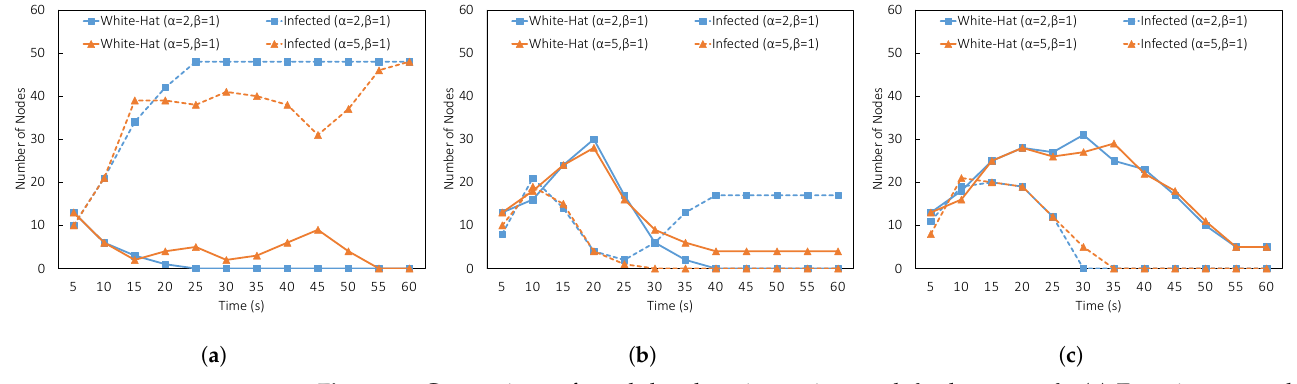
Figure 8. Comparison of result by changing ratio α and β where α > β . ( a ) Experiment result ( L = 5, α = { 2,5 } , β = 1). ( b ) Experiment result ( L = 10, α = { 2,5 } , β = 1). ( c ) Experiment result ( L = 20, α = { 2,5 } , β = 1). Table 2. Comparison of parameter settings. Yes: Succesful Diffusion; No: Unsuccessful Diffusion. Experiment Settings α β L = 5 L = 10 L = 20 Fixed Initial Lifespan N/A N/A No